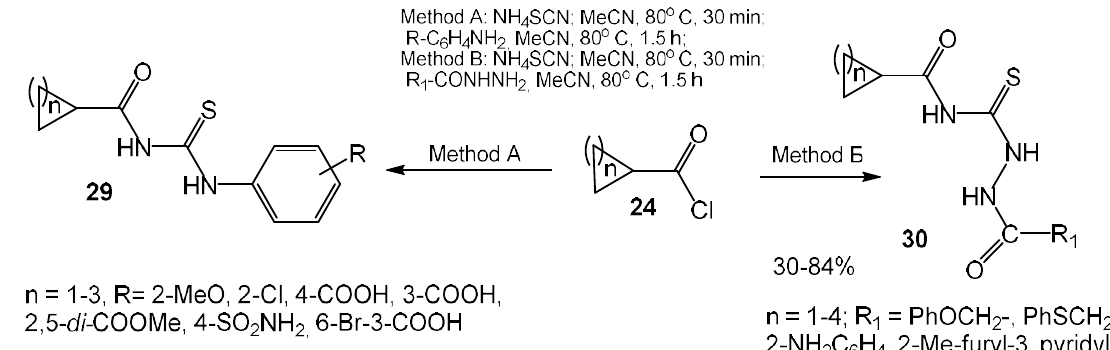
Fig. 9. “One-pot” synthesis of N- cycloalkylcarbonyl- N ′-arylthioureas and N- cycloalkylcarbonyl- N ′-acyl-(aroyl-, hetaroyl-)thiosemicarbazides